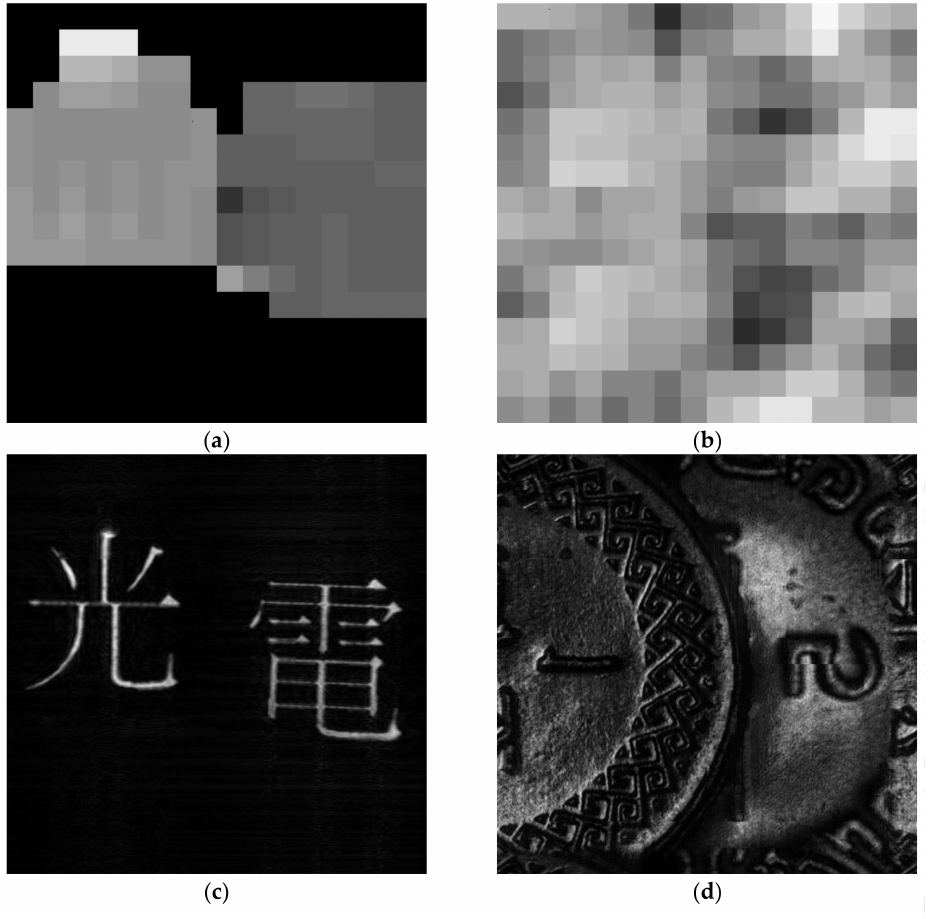
Figure 7. ( a ) Depth map of hologram “A” obtained with our proposed method ( M = 32) with filtering; ( b ) Depth map of hologram “B” obtained with our proposed method ( M = 32) with filtering; ( c ) EDF image of hologram “A” reconstructed with our proposed method ( M = 32) with filtering on the depth map; ( d ) EDF image of hologram “B” reconstructed with our proposed method ( M = 32) with filtering on the depth map.